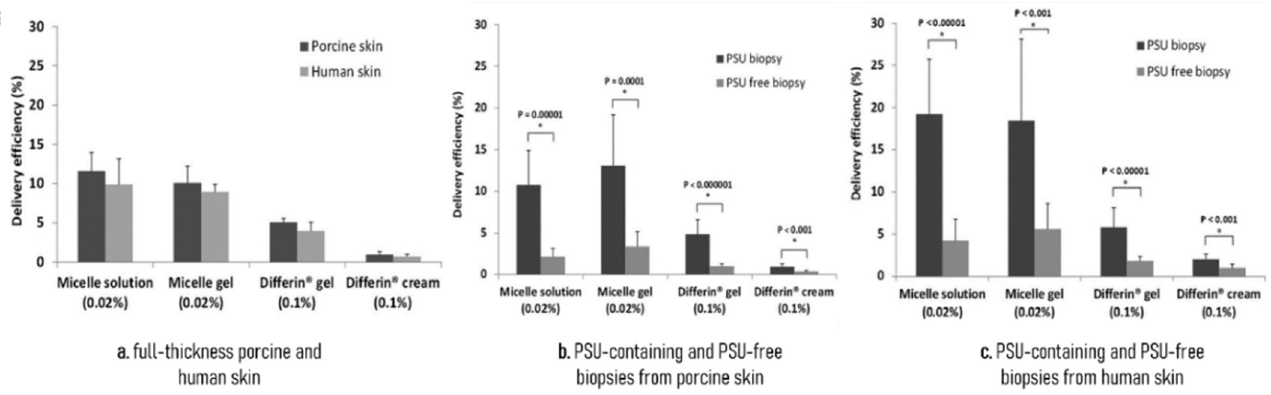
Figure 7. Comparison of ADA delivery efficiency of formulations (12 h after application) in finite dose of the ADA formulations, corresponding to 2 and 10 µg/cm 2 of ADA for the micelle and marketed formulations, respectively. Reprinted with permission from [42]). Copyright Royal Society of Chemistry 2018.